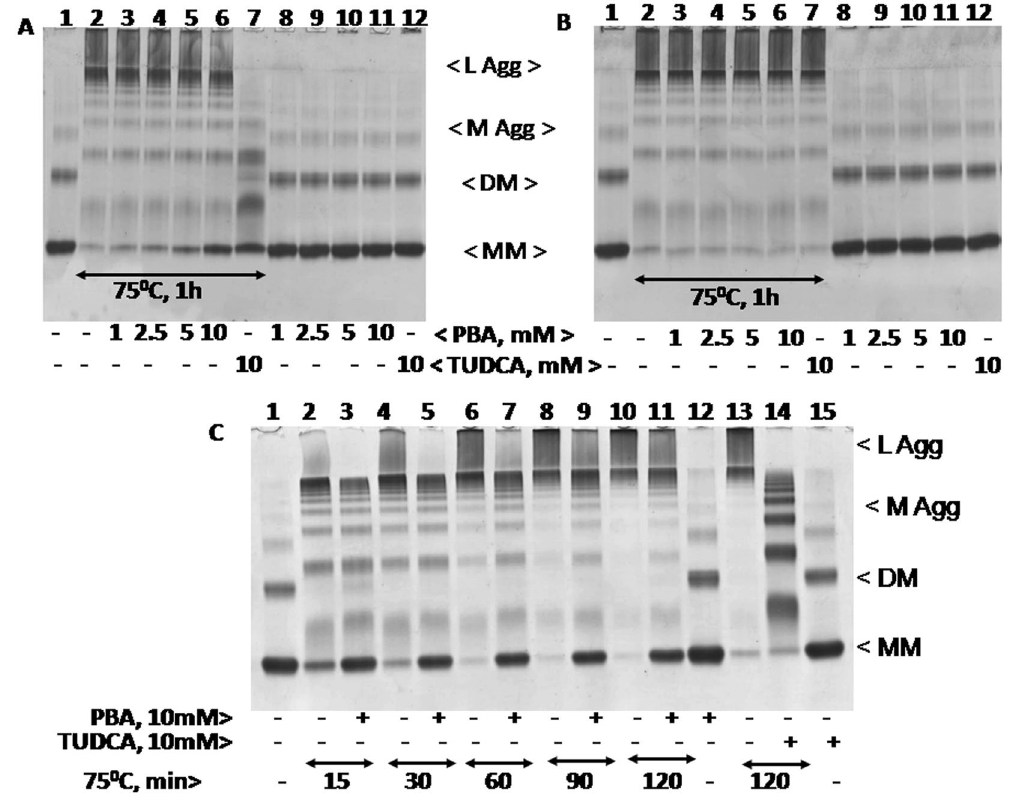
Figure 1. Heat induced aggregation of BSA in the presence of PBA or TUDCA: BSA (2 mg/ml) was heat treated at 75° C for 1 h in the presence and absence of different concentrations of PBA (1–10 mM) or 10 mM TUDCA either during heat treatment (Panel A) or after heat treatment (Panel B). Samples were analyzed by 8% Native- PAGE. The various lanes in Panel A and B are: 1, Control BSA; 2, heat treated BSA at 75° C for 1 h; 3–6, heat treated BSA in the presence of 1, 2.5, 5, and 10 mM PBA respectively; 7, heat treated BSA in the presence of 10 mM TUDCA; 8–11, native or control BSA in the presence of 1, 2.5, 5, and 10 mM PBA; 12, native BSA with 10 mM TUDCA. Abbreviations are as follows: L Agg and M Agg refer to large and medium aggregates; DM and MM refer to dimers and monomers respectively. Panel C represents heat induced aggregation of BSA at 75° C in the presence and absence of 10 mM PBA for different time periods (15, 30, 60, 90, and 120 min) or 10 mM TUDCA for 120 min. The various lanes are: 1, native BSA; 2, 4, 6, 8, and 10, BSA samples heat treated for 15, 30, 60, 90, and 120 min respectively; 3, 5, 7, 9, and 11, BSA samples heat treated for 15, 30, 60, 90, and 120 min respectively in the presence of 5 mM PBA; 12, native BSA with 5 mM PBA; 13, BSA heat treated for 120 min; 14, BSA heat treated for 120 min in the presence of 10 mM TUDCA; 15, native BSA with 10 mM